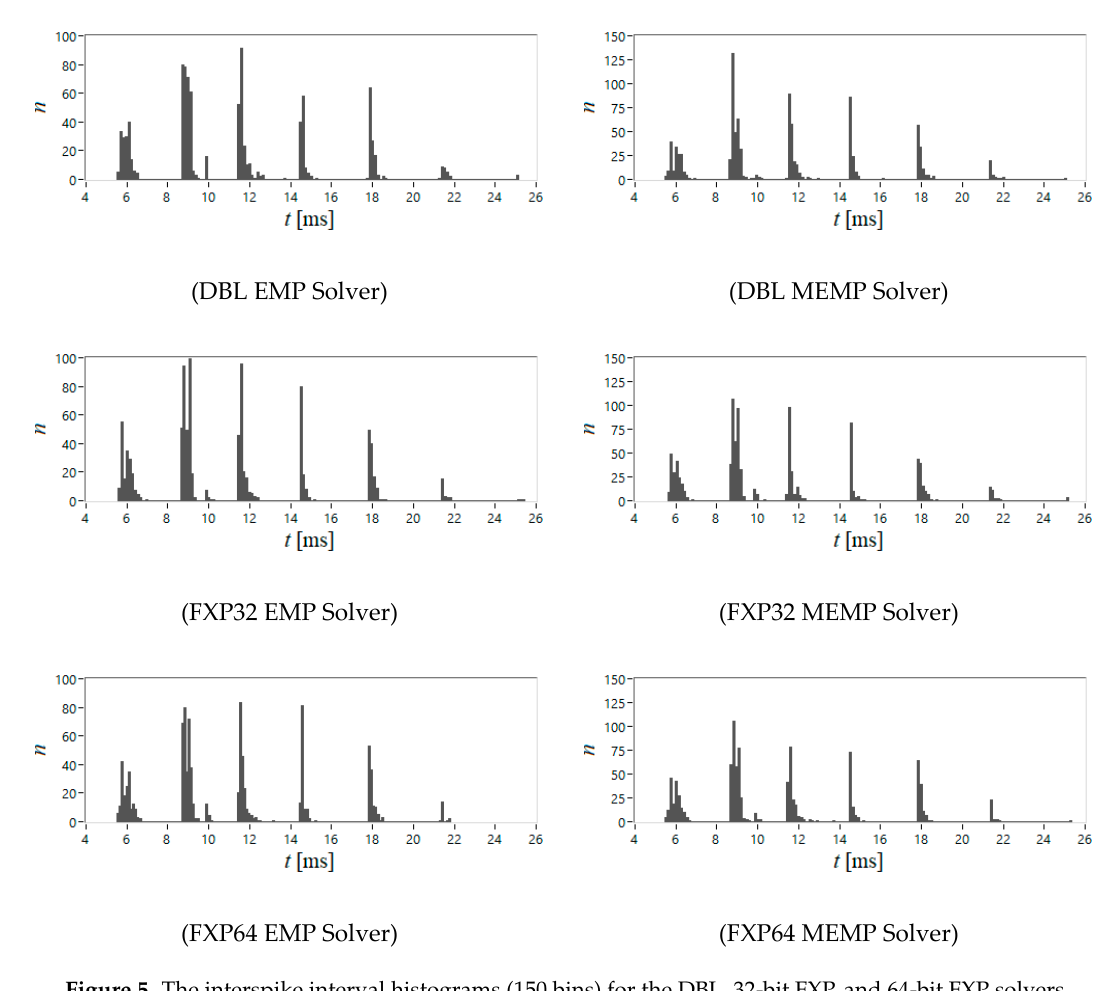
Figure 5. The interspike interval histograms (150 bins) for the DBL, 32-bit FXP, and 64-bit FXP solvers built using the methods EMP and MEMP.